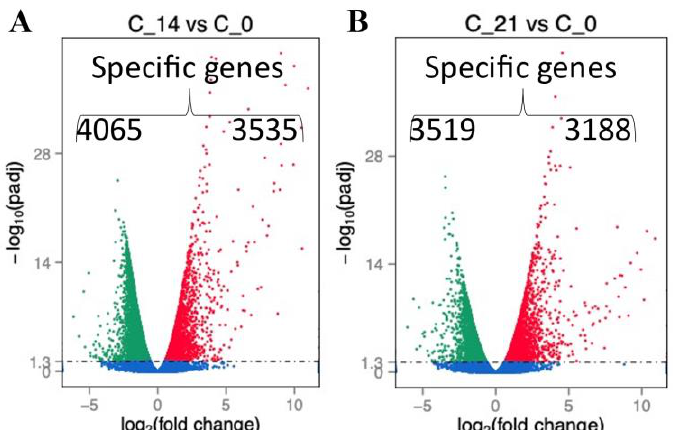
Figure 1. Distribution and number of genes that were differentially expressed at 14 (C_14) ( A ) and 21 (C_21) ( B ) days as compared to animals without surgery (C_0).